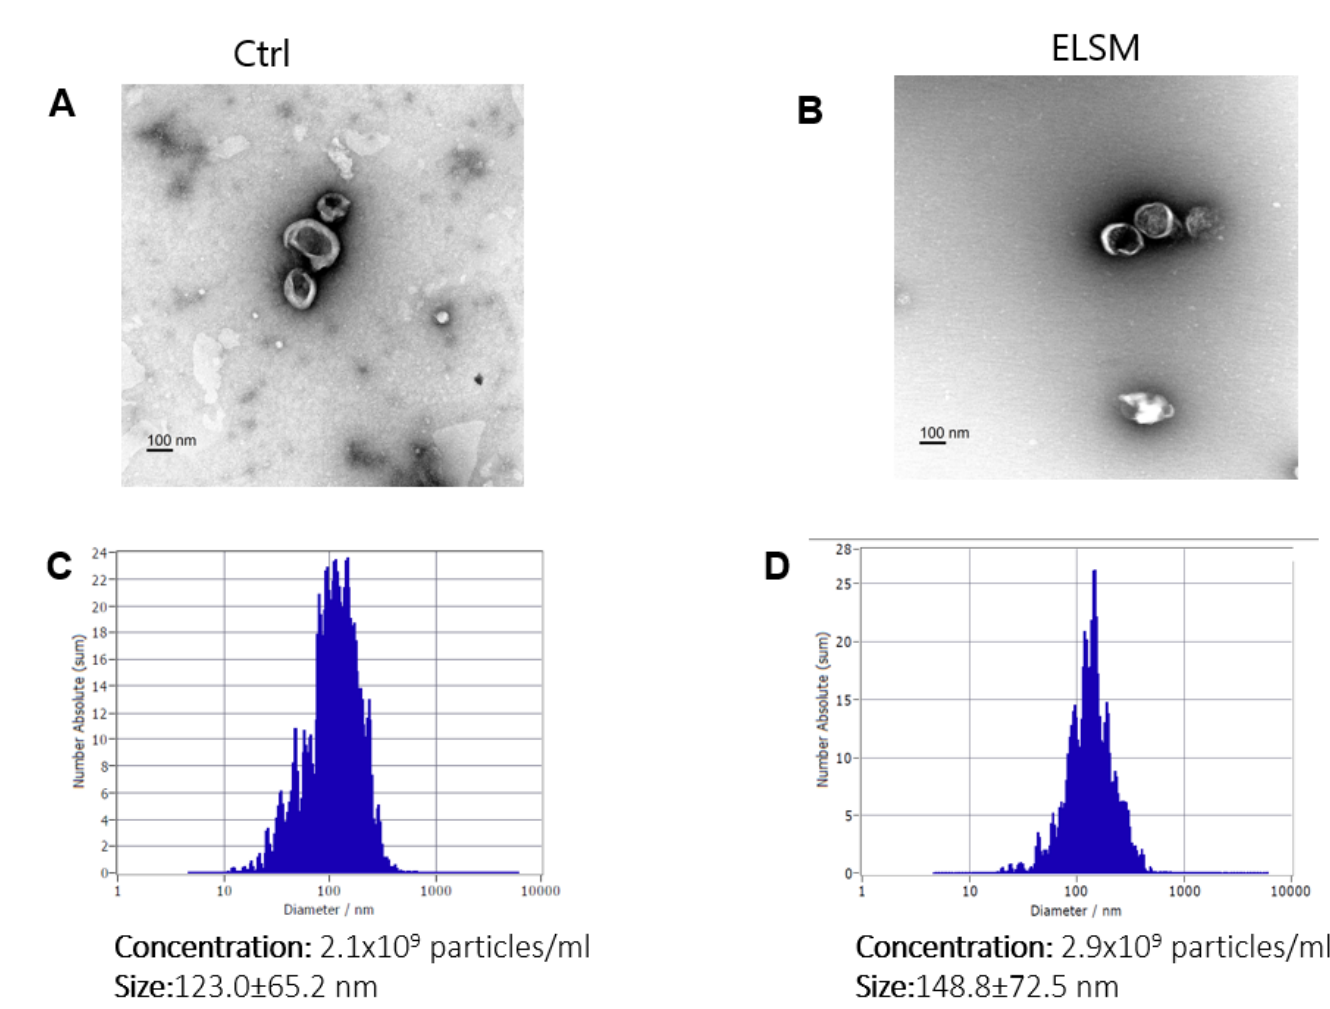
Figure 1. Characterization of EVs from C-MSC Ctrl and C-MSC ELSM . ( A , B ) Transmission electron micrograph images of EVs from C-MSC. Scale bar = 100 nm. ( C , D ) nanoparticle tracking analysis using ZetaView ® Particle Tracking Analyzer to measure the size and number of C-MSC-derived EVs with or without ELSM.